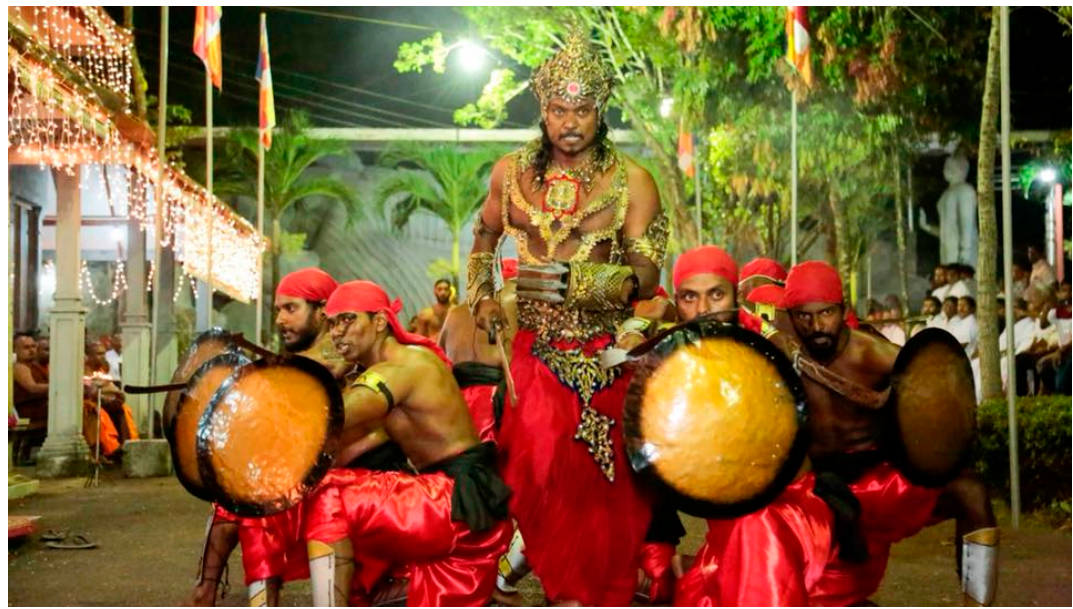
Figure 5. A group of Angampora students and their master performing in the Medin maha Perahera organized by the Sri Devram Maha Viharaya in Pannpipitiya on 24 March 2018. The picture was published on the Facebook Webpage Sri Devram Maha Viharaya (2018a).